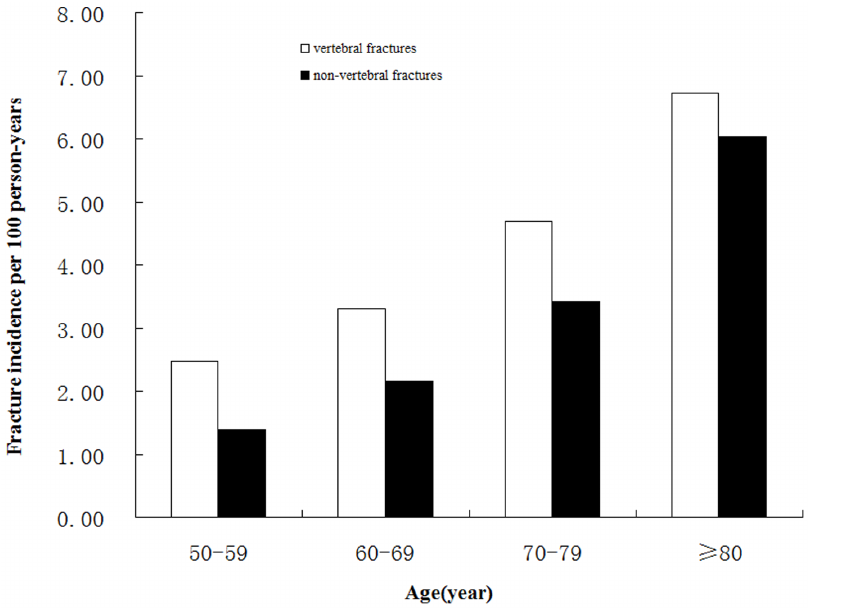
Figure 2. Incidence of vertebral and non-vertebral fractures per 100 person-years by age and site. Incidence of vertebral and non- vertebral fractures was significantly higher in the 60- to 69-year-old group, the 70- to 79-year-old group and the . 80-year-old group compared to the 50- to 59-year-old group (p , 0.001, respectively). In each group, the vertebral fracture prevalence was significantly higher than for non-vertebral fractures (p ,